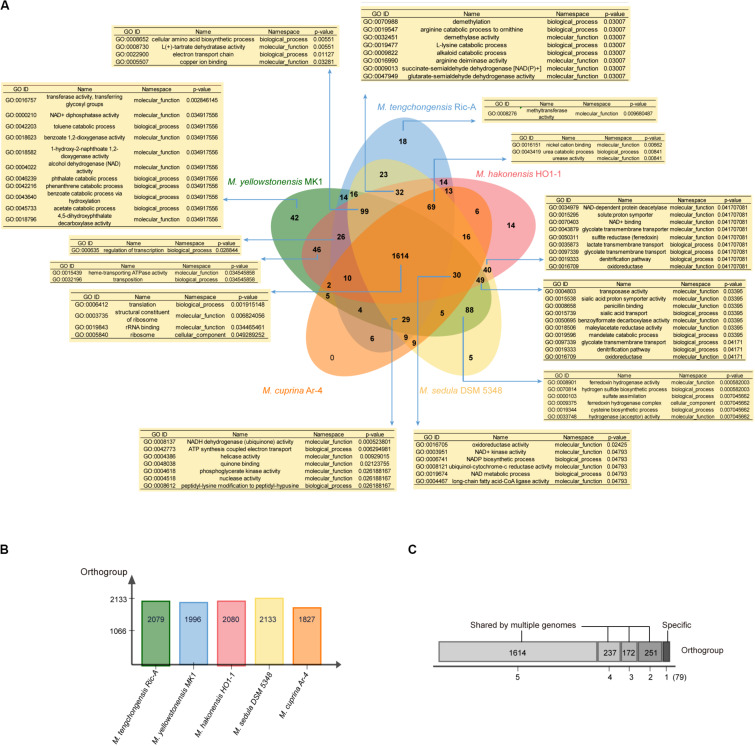
(A) Venn diagram showing the numbers of orthogroup including the core-genome (shared by all five Metallosphaera type strains), the accessory genome (shared by some but not at all of these strains), and strain-specific gene families in individual genomes; enriched Gene ontology (GO) terms (p < 0.05) in respective orthogroups are shown in the tables. (B) Bar chart showing the total numbers of orthogroup identified in each genome of the five Metallosphaera-type strains. (C) The total numbers of orthogroups of strain-specific gene families (=1) or the accessory genome (shared by 2, 3, and 4 strains) and core-genome of five Metallosphaera-type strains.